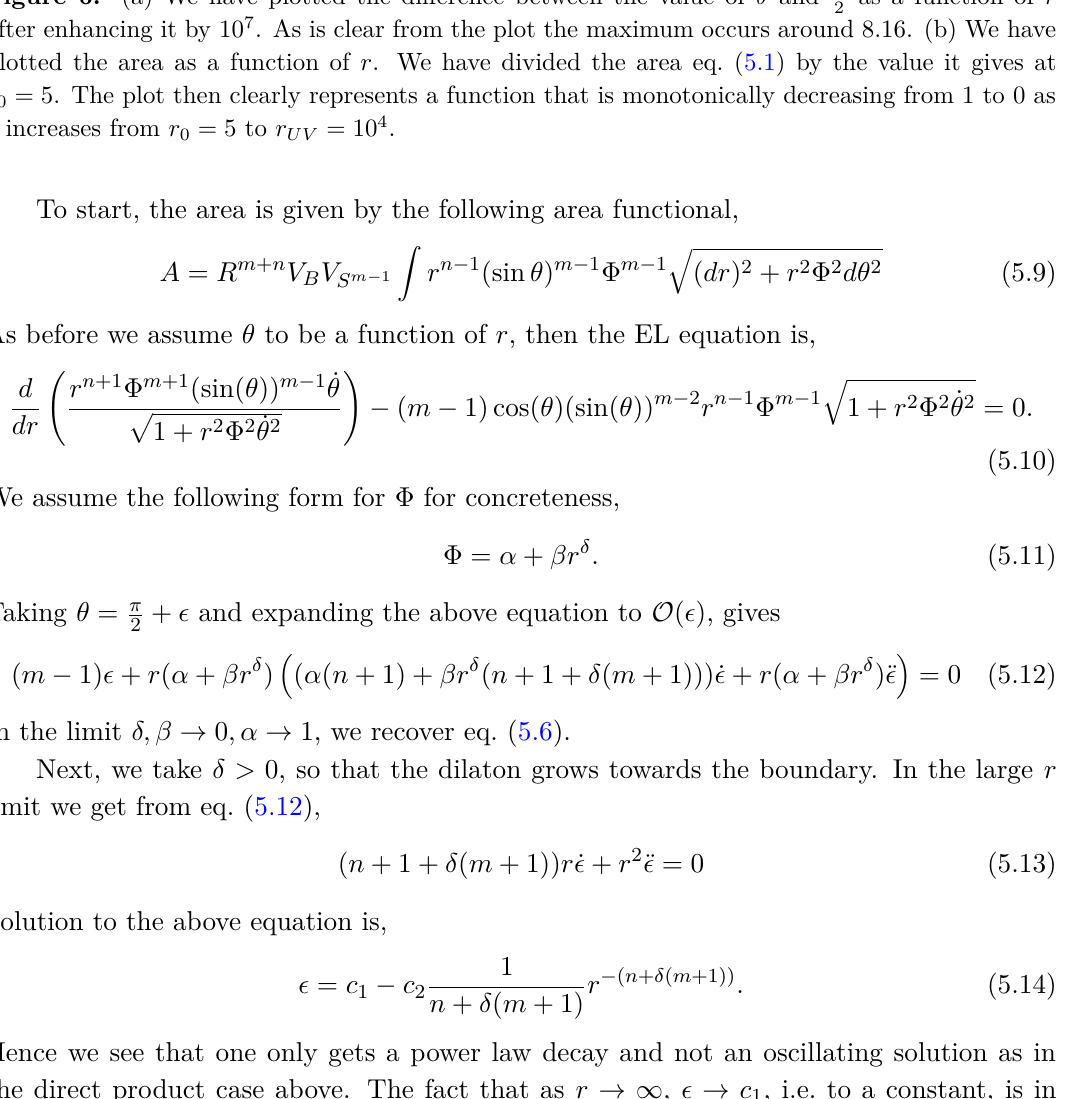
as a function of r 2